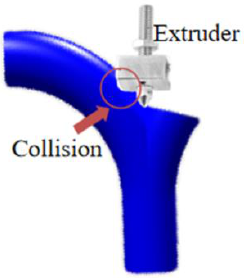
Figure 5. Collision between the nozzle and the printed model occurs.